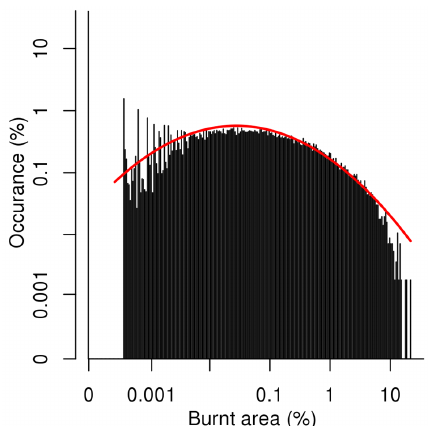
Figure A1. Distribution of burnt areas in MODIS Collection 6 MCD64A1 burnt area product (Giglio et al., 2018) and (red line) fitted normal distribution of logit transformed burnt areas greater than 0.